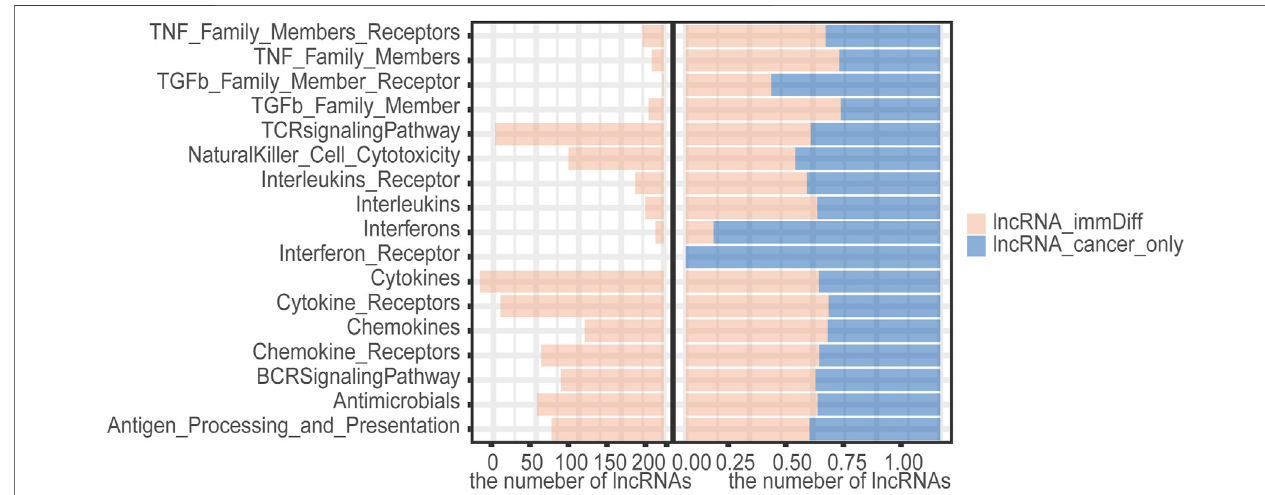
FIGURE 5 | The number of candidate aberrant immune lncRNAs in the immune pathway and the ratio of candidate aberrant immune lncRNAs in the immune pathway to HCC-speci fi c lncRNAs.